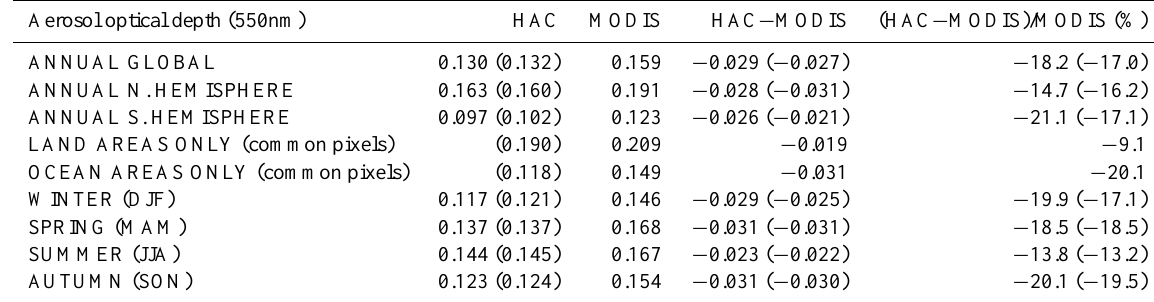
Table 2. Total mid-visible (550nm) aerosol optical depth (AOD) for HAC and MODIS, and their absolute and relative differences. The values in brackets are for common HAC–MODIS